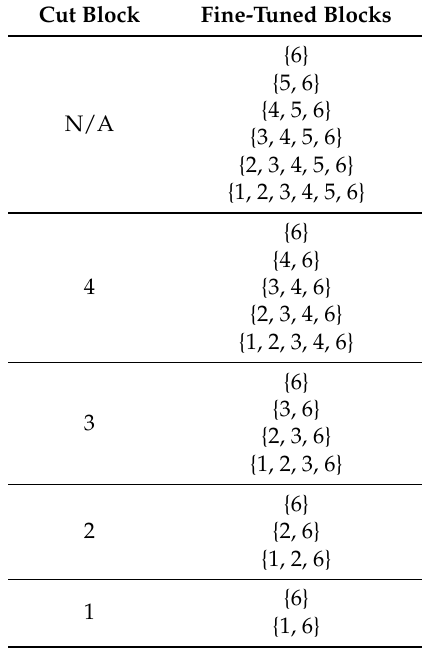
Table 4. The 20 network configurations applied to VGG16, ResNet50, and Inception-v3, respectively. N/A: Not